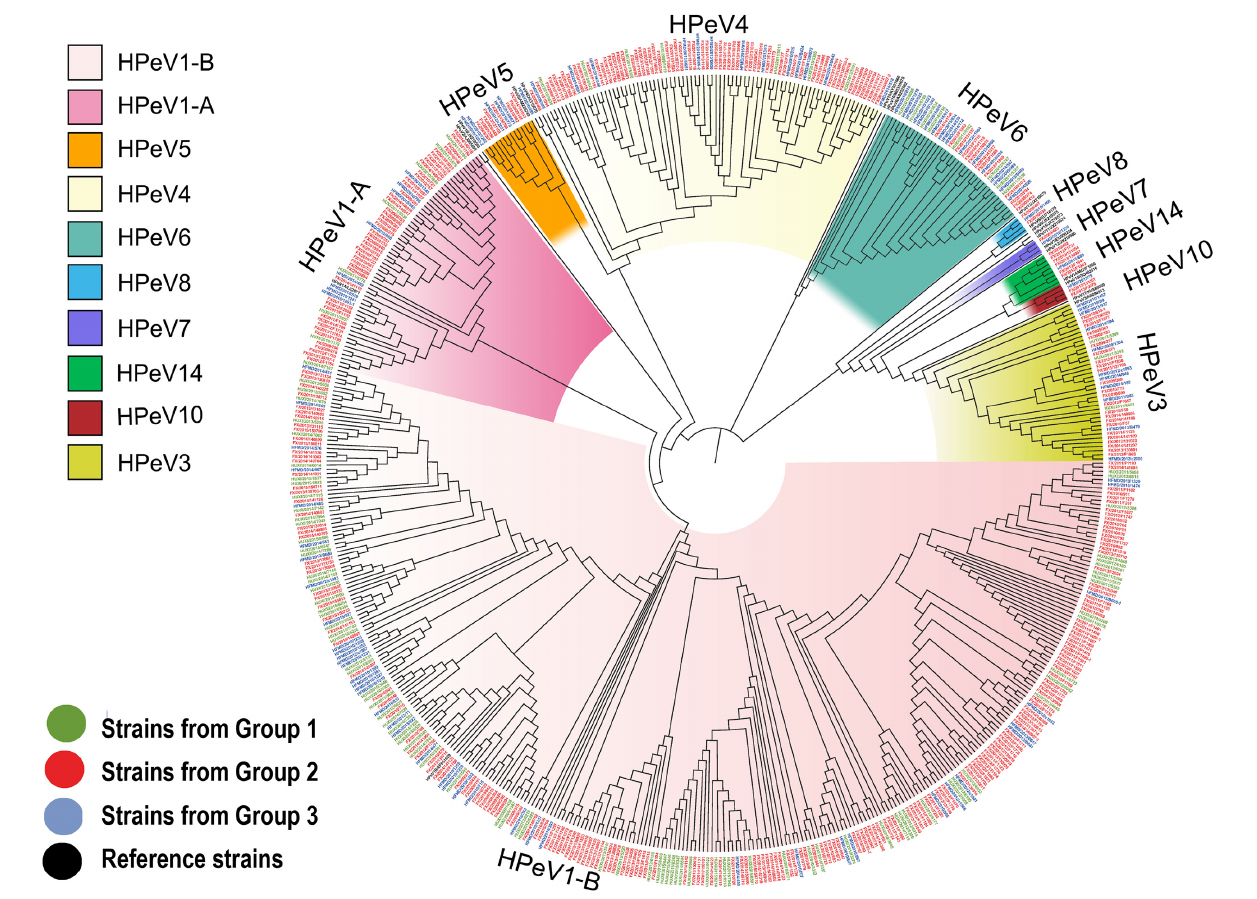
FIGURE 2 | Phylogenetic analysis of all the HPeV strains from our study based on the compete VP1 sequence. The phylogenetic trees were constructed with maximum likelihood method with 1,000 replicates using MEGA 7.0. The strains of black names in the figure were the reference strains (HPeV1A/L02971, HPeV1B/EF051629, HPeV2/AJ005695, HPeV3/AB084913, HPeV4/DQ315670, HPeV5/AM235749, HPeV6/AB252582, HPeV7/EU556224, HPeV8/EU716175, HPeV9/JX219575, HPeV10/GQ402516, HPeV11/JX219574, HPeV12/JX219566, HPeV13/JX219579, HPeV14/MG571809, HPeV15/JX219573, HPeV16/JX219580, HPeV17/KU885089, HPeV18/KY931660, and HPeV19/MH339678). The strains of green names with the beginning of “HUXI” were isolated from patients with Group 1 (patients with acute respiratory tract infection). The strains of red names with the beginning of “FX” were isolated from Group2